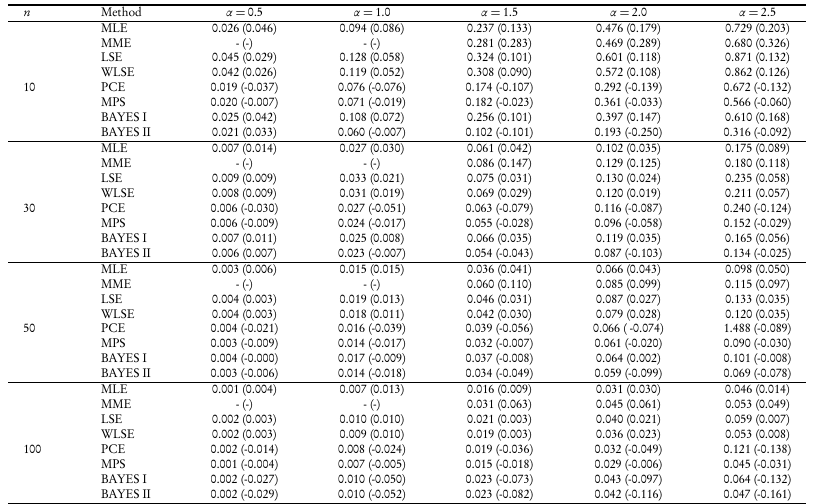
MSEs and average biases (values in parentheses) of different estimates of α .